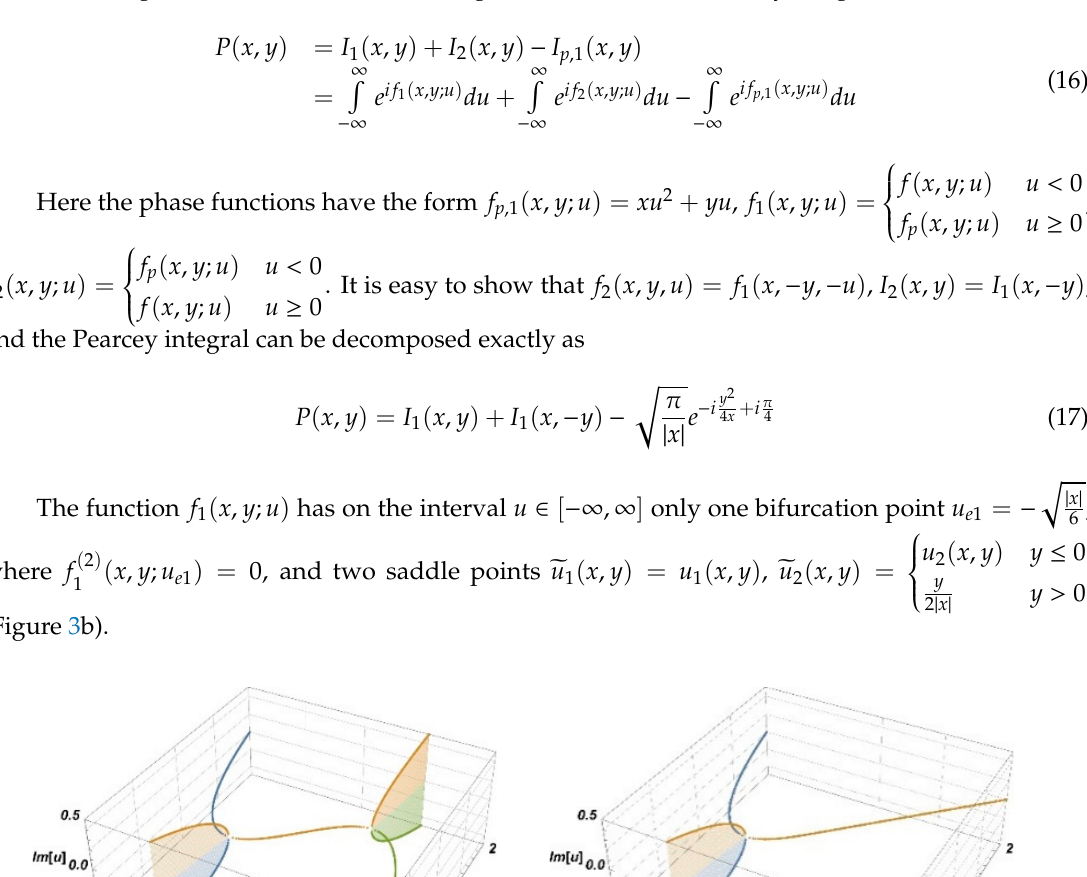
Figure 2. Function